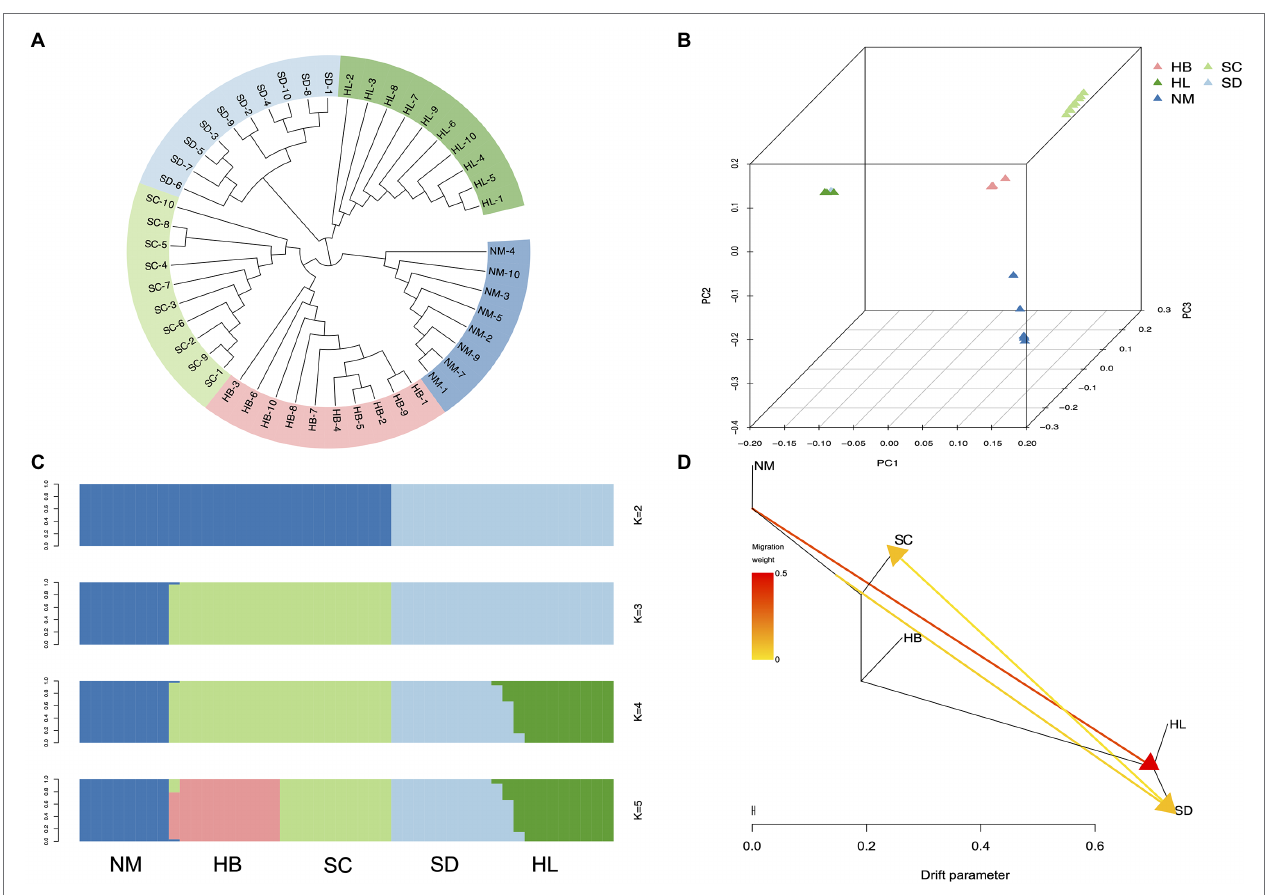
FIGURE 4 | Population structure analysis. (A) Neighbor-joining phylogenetic tree of the 48 sequenced individuals. (B) Each point refers to an individual, where colors distinguish populations. (C) Population genetic structure of all SNPs estimated on the basis of ADMIXTURE analysis with K = 2 to 5. (D) Maximum-likelihood tree and migration events among 5 populations of A. edgeworthii . Migration events are colored by their